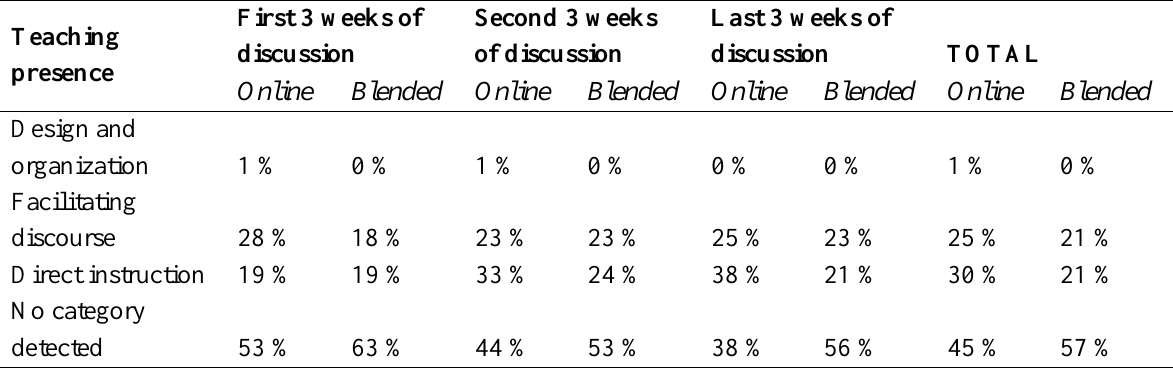
Comparison of Coding Results for Teaching Presence between Courses Teaching presence Design and